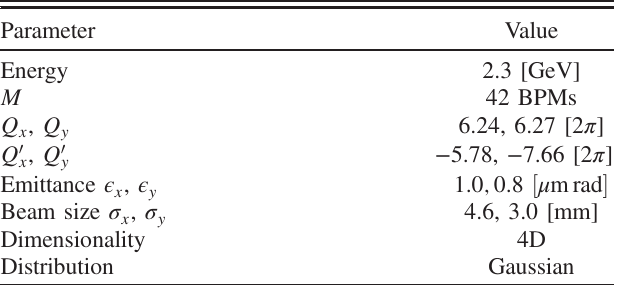
TABLE I. Parameters of the MADX - PTC tracking simulations with the PS